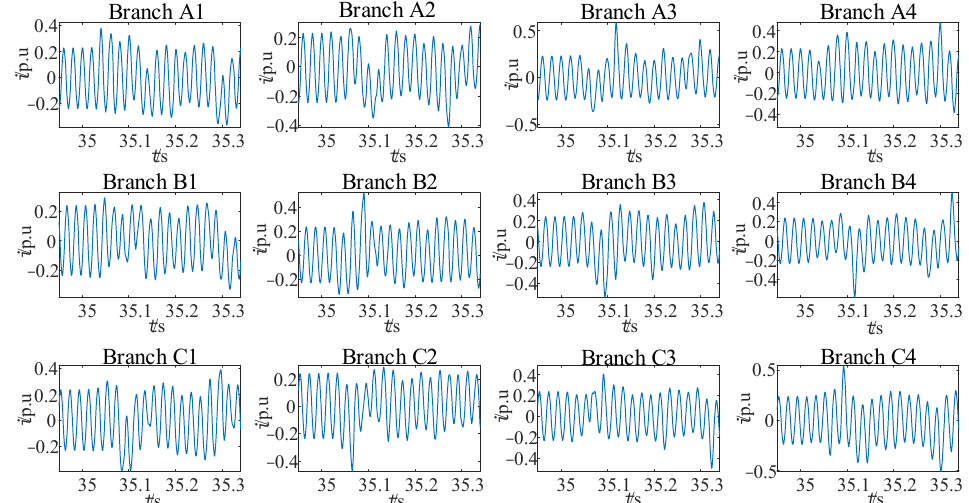
Figure 3. The transient current of waveform stator branches (the inter-turn short circuit fault occurs at t = 35.0 and in rotor branch A2).